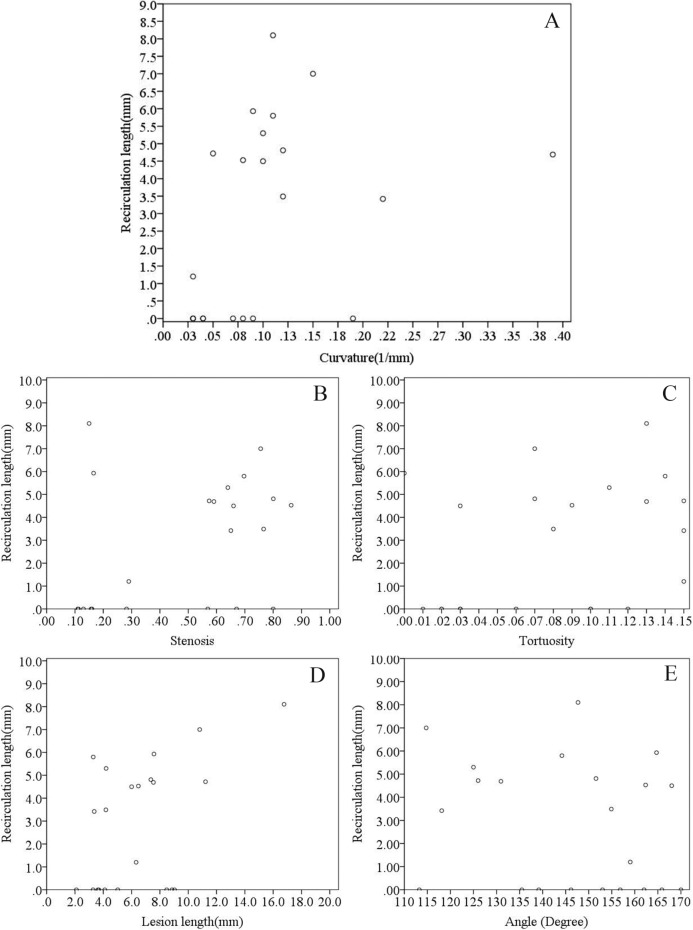
Relationship among stenosis severity, tortuosity, curvature, angle, lesion length with length of recirculation zone in the reconstructed patient-specific coronary arteries.A: effect of curvature on maximum wall shear stress; B: effect of stenosis severity (percent diameter stenosis) on maximum wall shear stress; C: effect of tortuosity on maximum wall shear stress; D: effect of lesion length on maximum wall shear stress; E: effect of angle of the lesion segment on maximum wall shear stress.